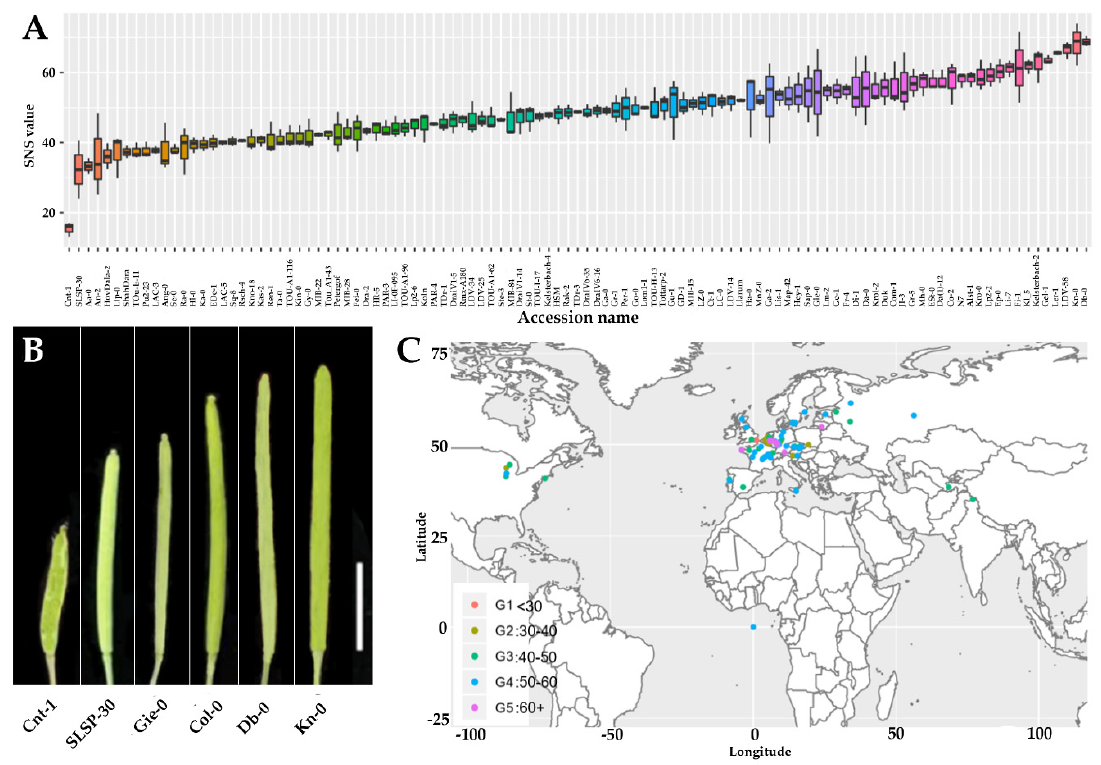
Figure 1. Arabidopsis accessions display significant natural variations in seed number per silique (SNS). ( A ) Boxplot of seed number in 107 Arabidopsis accessions. ( B ) Siliques of low, medium, and high SNS accessions (Bar = 5 mm). ( C ) Geographic distribution of accessions. Groups 1 to 5 correspond to seed number ranking (from low to high).